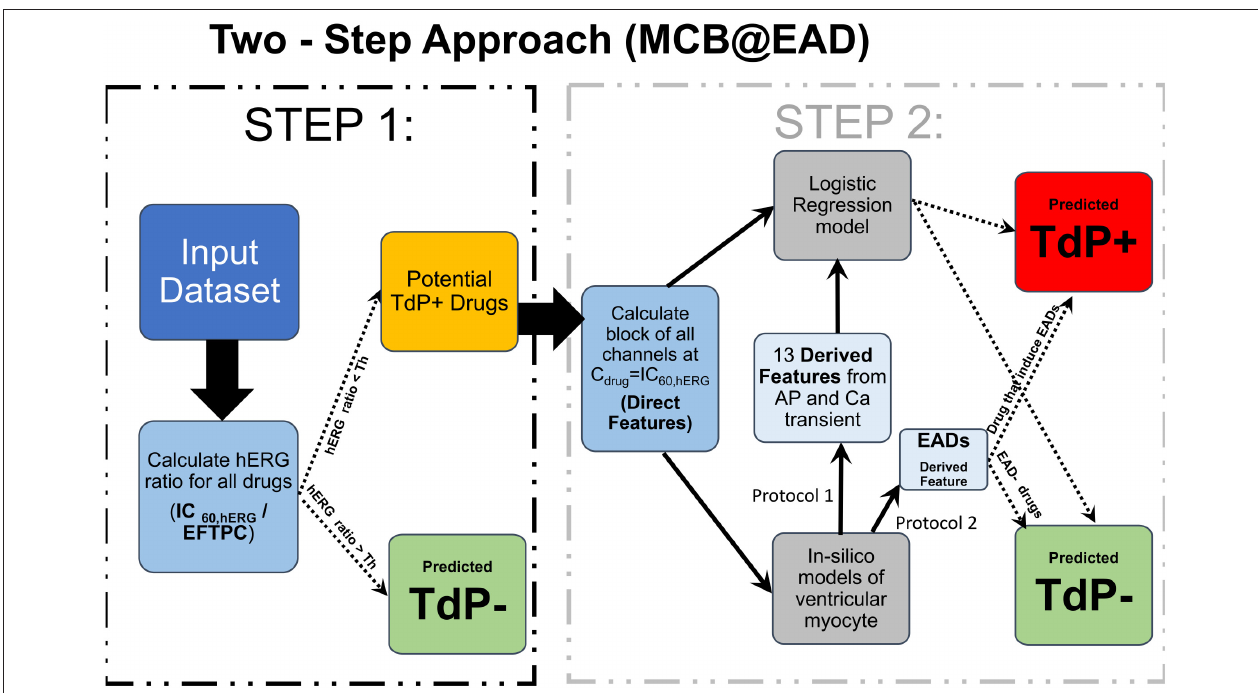
FIGURE 1 | Schematic representation of the MCB@EAD two-step approach. In-vitro assay datasets are used to obtain the drug-induced blocks of multiple ion-channels at drug concentrations equal to IC 60, hERG . hERG ratio ( IC 60, hERG EFTPC ) is used as the classification criteria in the first step. Drugs that do not result in 60% hERG block at concentrations well above their maximum EFTPC are classified as non-torsadogenic (TdP − ). hERG ratio thresholds of 50, 100, 150, and 200 were tested, and the one that provides the best TdP risk discrimination was chosen for the particular datasets. The remaining drugs are considered to be potentially torsadogenic and analyzed in the second step. The drug-induced blocks of multiple ion-channels at 60% hERG block concentrations (direct features) are used as inputs to the logistic regression model for TdP risk classification or used to simulate drug-induced changes in action potential (AP) and calcium (Ca) transients using different protocols. The derived features are extracted from the AP and Ca transients. These derived features are then used to train the logistic-regression model for TdP risk classification or used directly (e.g., in case of EADs) to classify drugs to TdP + and TdP −